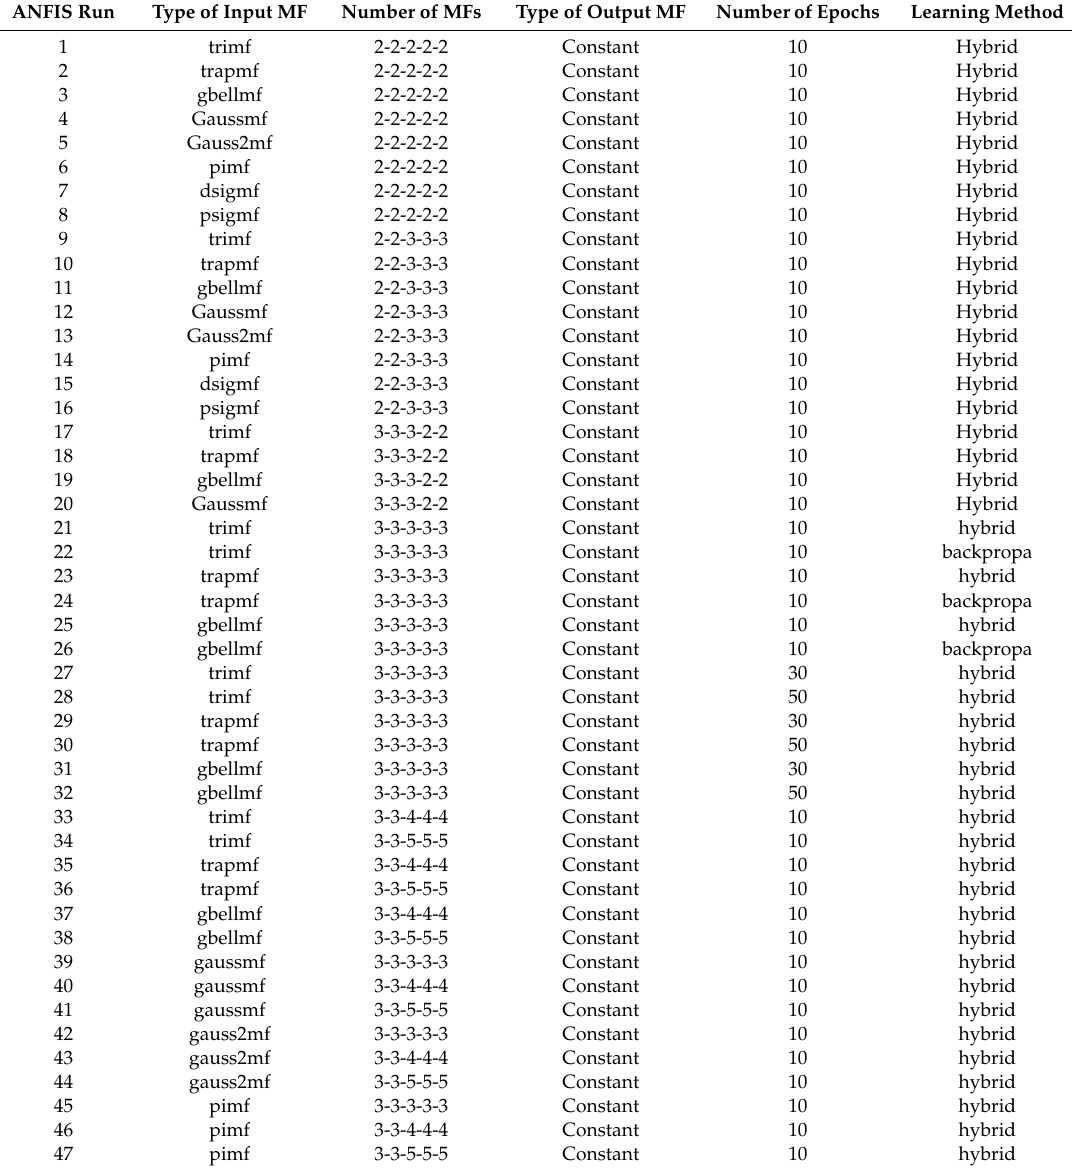
Table3. DifferentconfigurationsoftheselectedANFISarchitecturesregardingconstantoutputmembership function